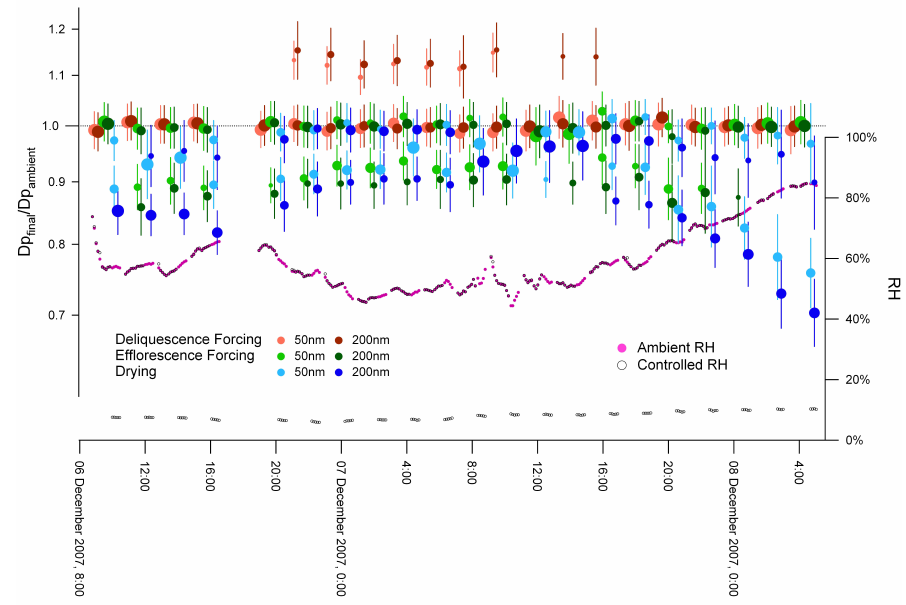
Fig. 9. A time series of AS-TDMA measurements from the winter campaign. The point and error bar markers follow the convention described in Sect.